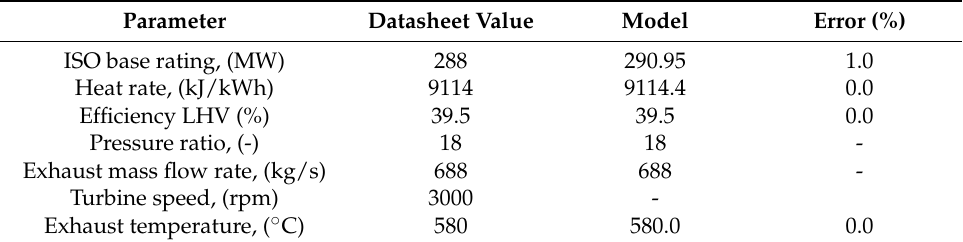
Table 4. Comparison between Siemens SGT5 4000F and the model developed